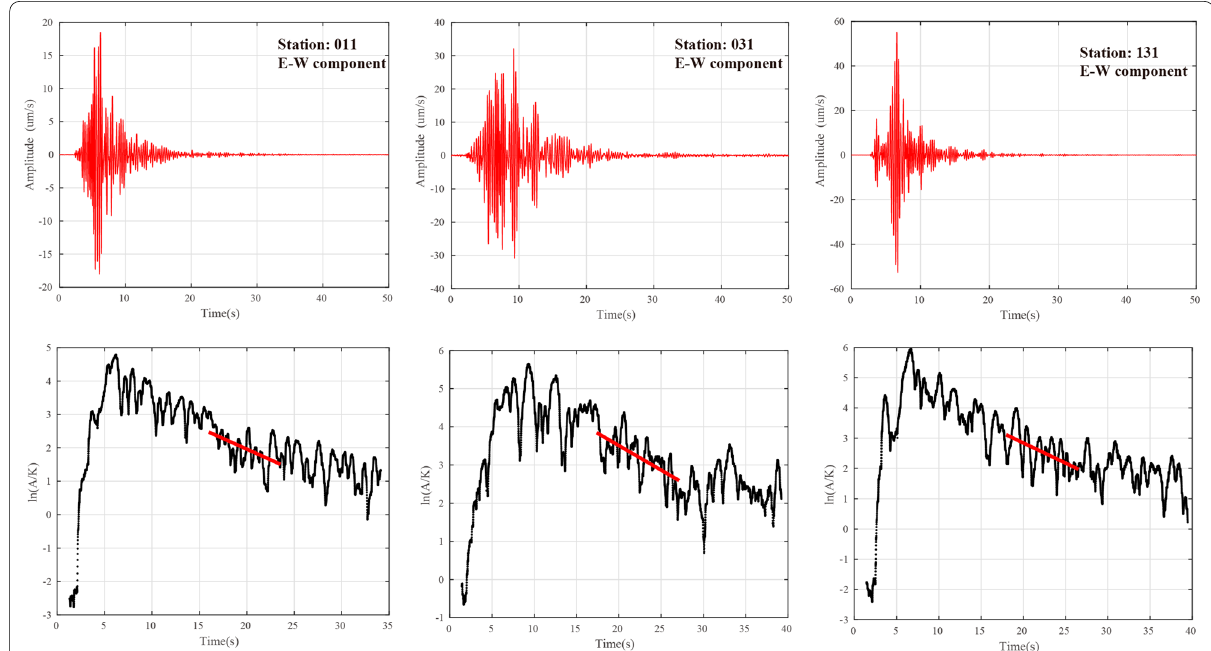
Fig. 7 The function ln [ A ( f | r , t )/ K ( r , a ) ] versus lapse time t of the selected coda windows at three stations. Coda waves are shown in red in the upper graph, and the lower graphs illustrate the relationship that the function ln [ A ( f | r , t )/ K ( r , a ) ] versus lapse time t along with least-squares fits of selected signal